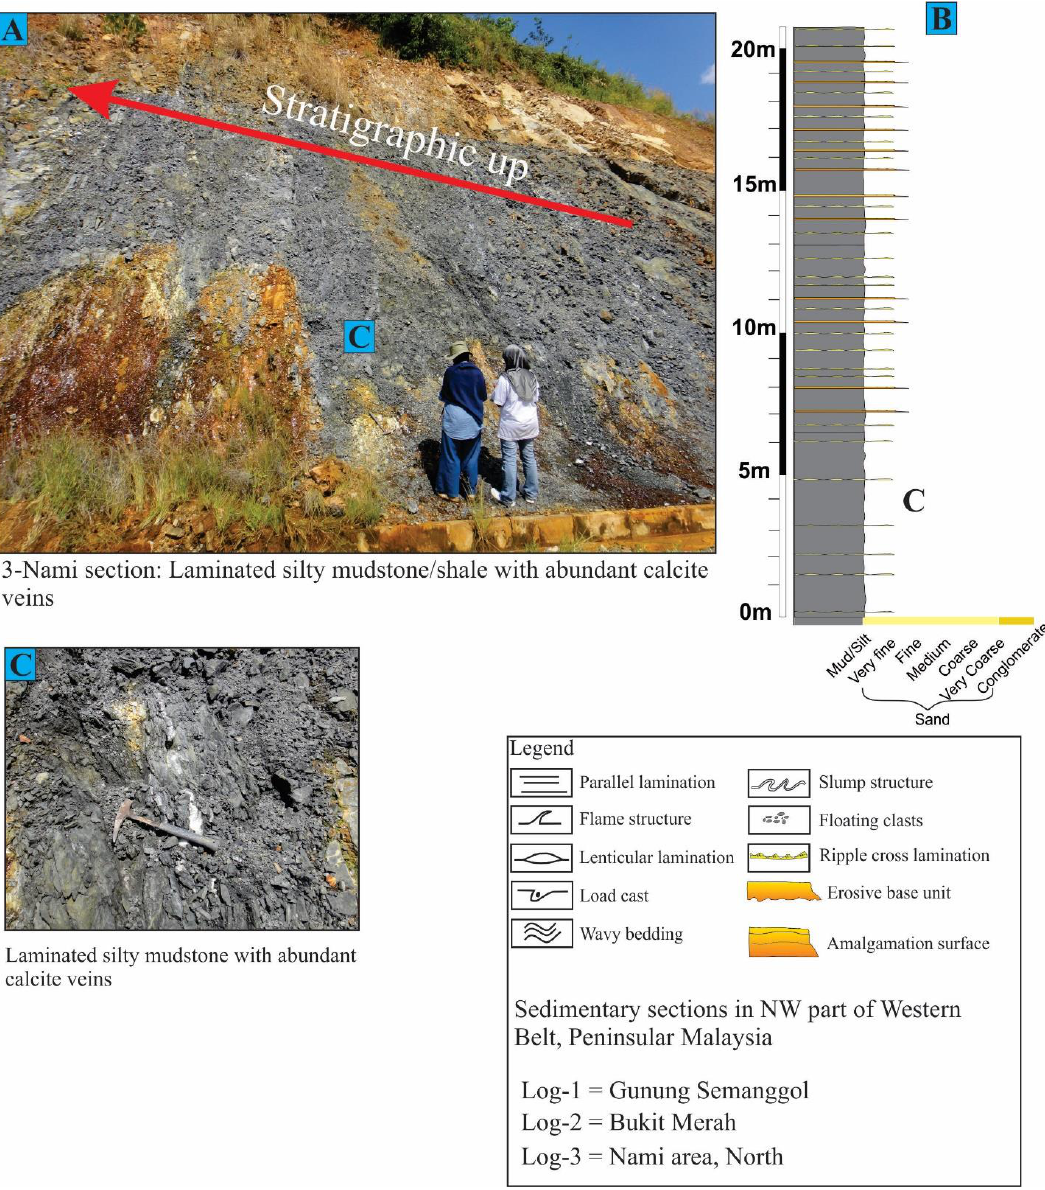
Figure 4. ( A – C ) Stratigraphic log and field photographs of the Semanggol Formation, 3-Nami section, North Kedah.